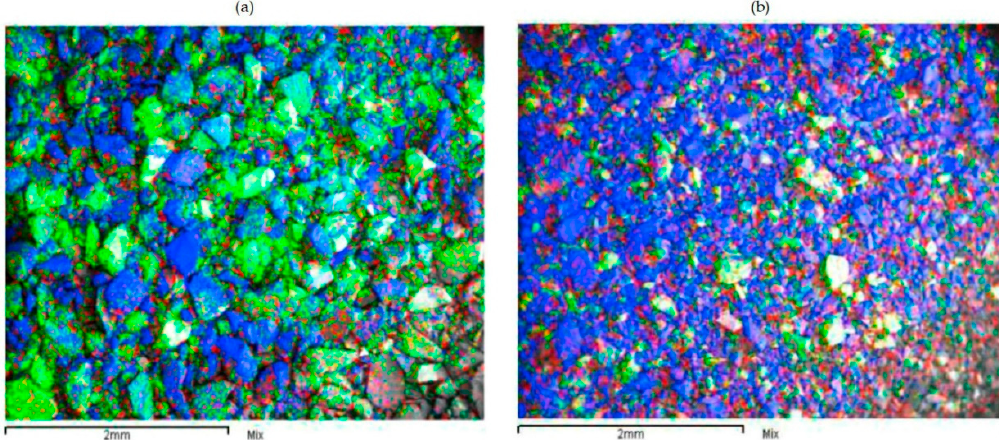
Figure 10. SEM image shows RA residues obtained under standard conditions ( a ) and with FeSO 4 as a reducing agent ( b ). Manganese (green), copper (red) and silica (blue).